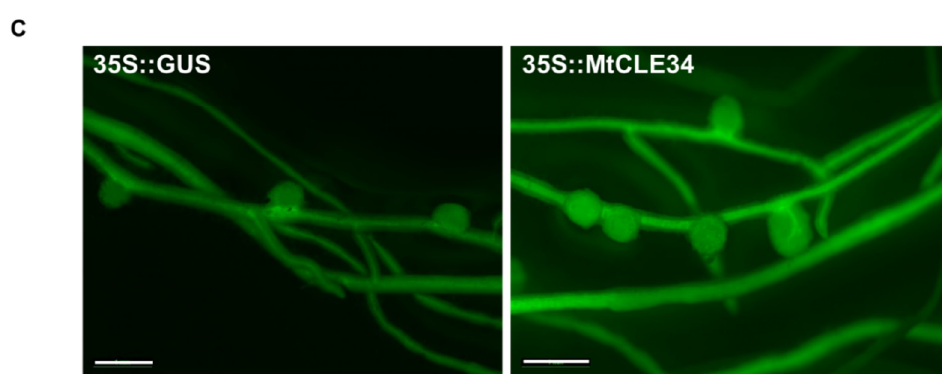
Figure 4. Overexpression of the MtCLE34 genes does not affect nodule number. ( A ) The expression level of the MtCLE34 gene in GFP-positive transgenic roots transformed with the 35S :: GUS (GUS_OE, control) or 35S :: MtCLE34 construct. *** indicate statistically significant differences p < 0.001. ( B ) Number of nodules on transgenic roots of the A17 line carrying the 35S:GUS (control) or 35S:MtCLE34 construct in four weeks after rhizobial inoculation. ( C ) Symbiotic nodules on GFP-positive transgenic roots carrying the 35S:GUS (control) or 35S:MtCLE34 construct. Bars = 1000 µm.